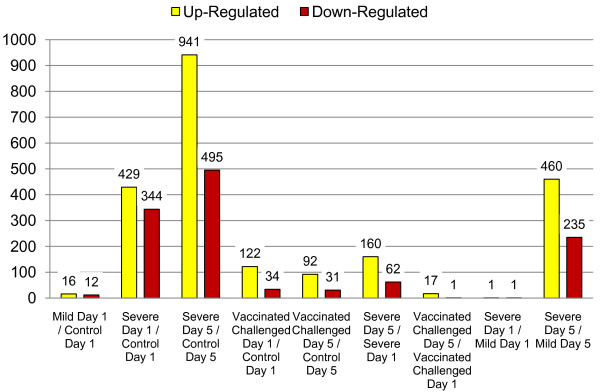
Direction of response. Directionality of significantly differentially expressed genes found in various contrasts with a minimum fold change of 1.5. For each contrast, up-regulated means there is greater expression in the first group, down-regulated means there is greater expression in the second group listed (q-value < 0.05).